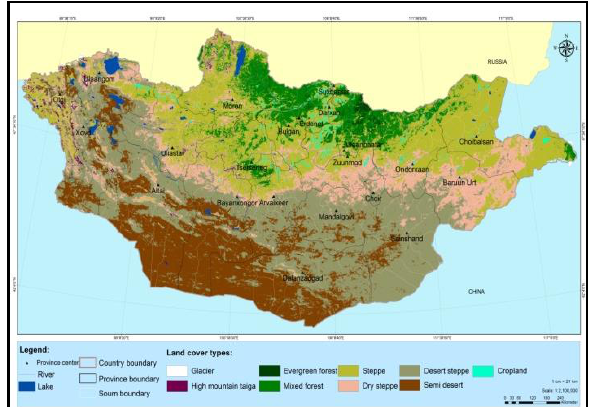
Figure 1. Land cover map of Mongolia and that contains major land cover types such including high mountain, steppe and desert area derived from MODIS/Aqua 250m